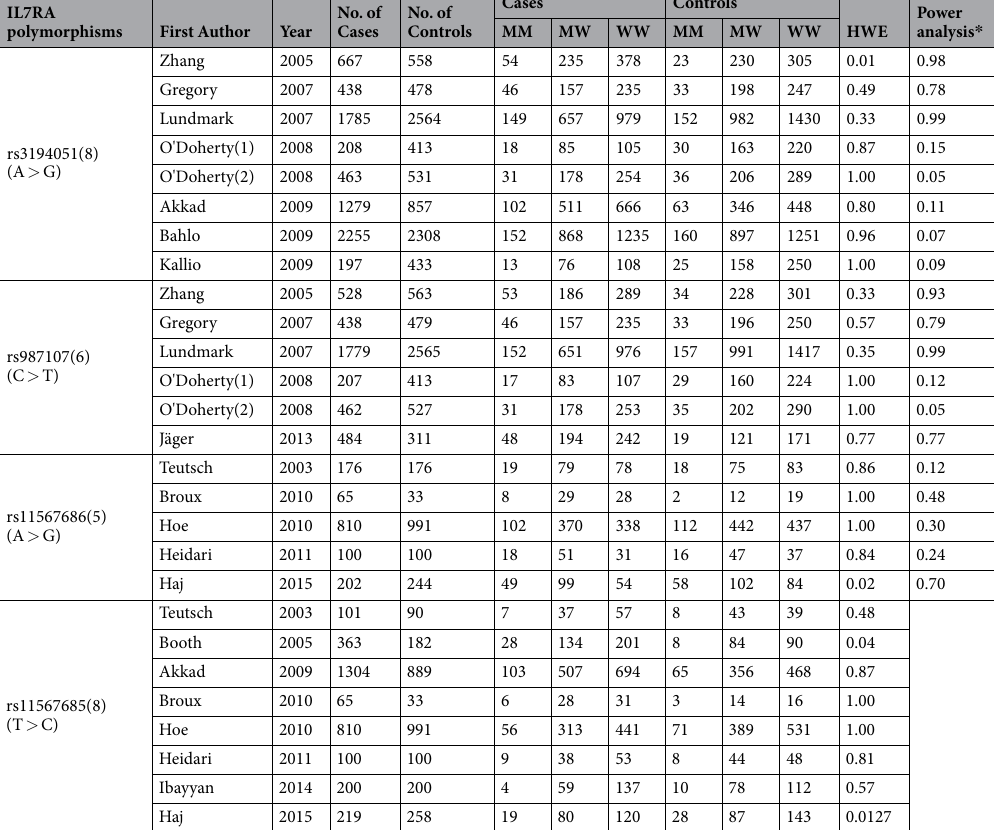
Table 2. IL7RA genotypic distribution among MS cases and controls in the included studies. Note: MM: homozygous mutant genotype; MW: heterozygous mutant genotype; WW: wild genotype; NA: not available; power analysis * : rs3194051 (recessive model); rs987107 (recessive model); rs11567686 (dominant